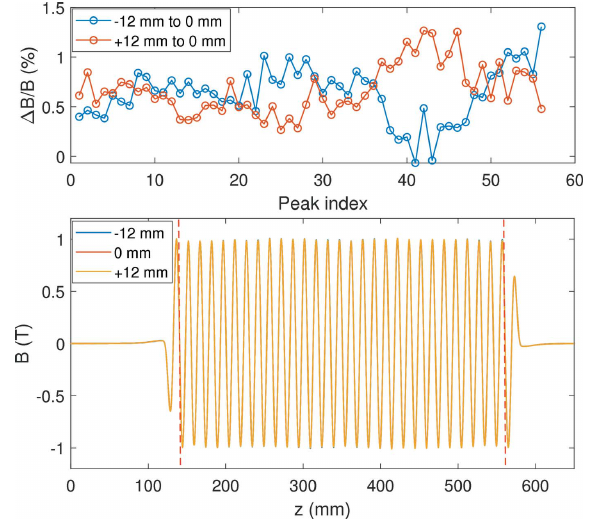
Figure 10 Local field map of the SCU measured by three Hall probes spaced 12 mm apart. The deviation of the peak values between the off-center probes and the central probe are given as a percentage.